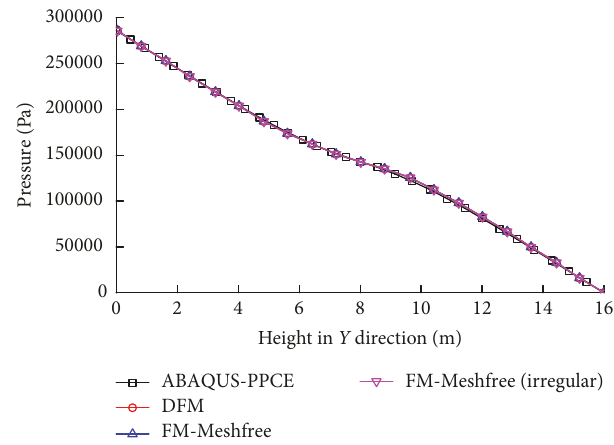
Figure 9: The pressure profile for a vertical section taken through the center of the fractured media.